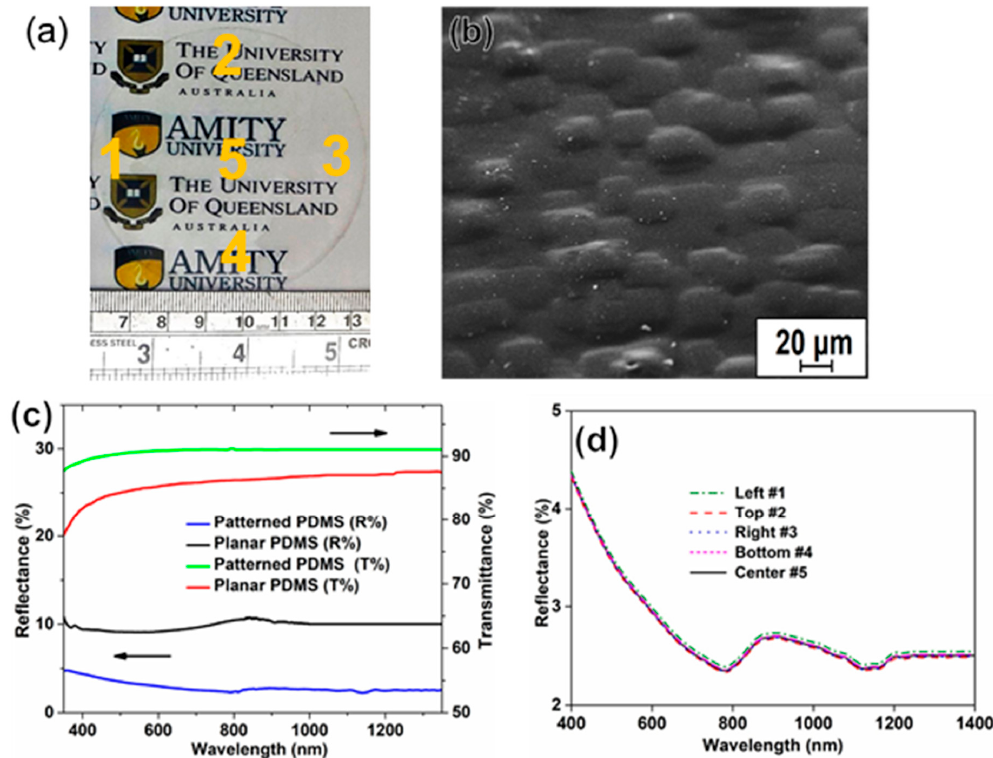
Figure 6. ( a ) Digital image of the patterned PDMS membrane ( b ) SEM image of the hierarchically patterned PDMS; ( c ) transmittance and reflectance spectrum comparison between planar and patterned PDMS. ( d ) Variation in surface reflectance across different regions of patterned PDMS; note: Point 1 is the extreme left area, point 2 is the top area, point 3 is the extreme right area, point 4 is the bottom area, and point 5 is the central area.